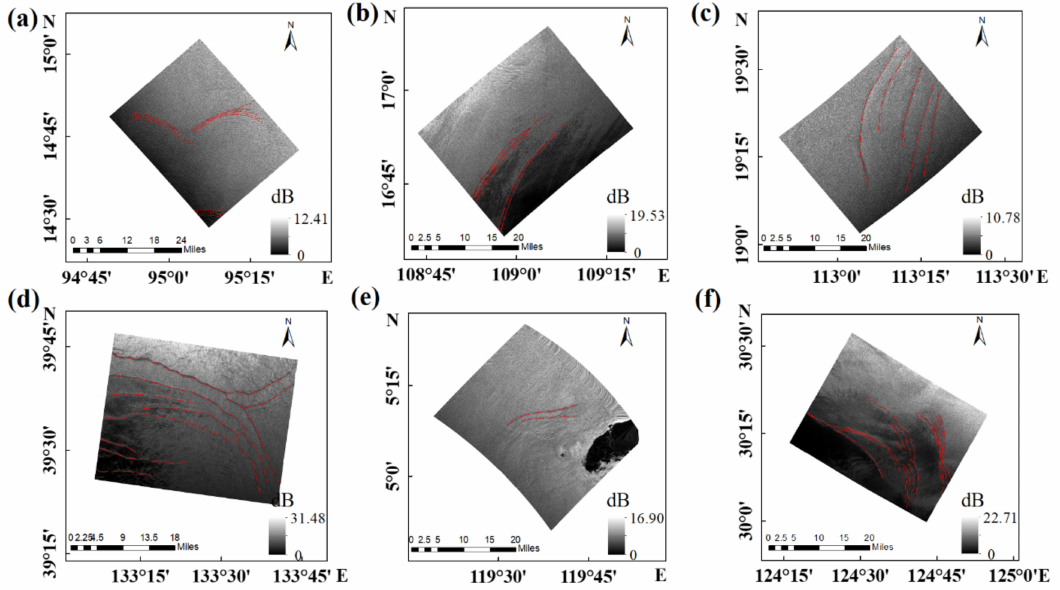
Figure 3. Images of ISWs from InIRA onboard Tiangong-2, where the red solid lines are the crest lines of the leading ISWs: ( a ) Andaman Sea, 9 September 2018 UTC; ( b ) SCS, 30 May 2018 UTC; ( c ) SCS, 8 June 2018 UTC; ( d ) Sea of Japan, 23 September 2016 UTC; ( e ) Celebes Sea, 17 April 2018 UTC; ( f ) waters near the Yangtze River Estuary, 7 April 2019